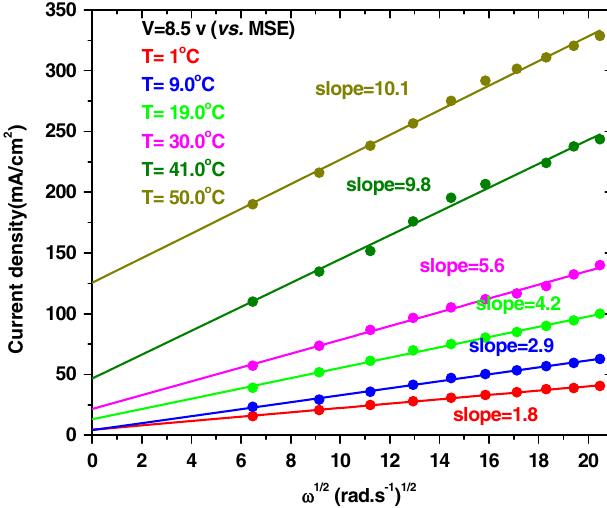
FIG. 5. (Color) The limiting current density of Nb disk electrode in 1:10 volume ratio HF and H square root of rotation rate at a potential 8.5 V (vs MSE).